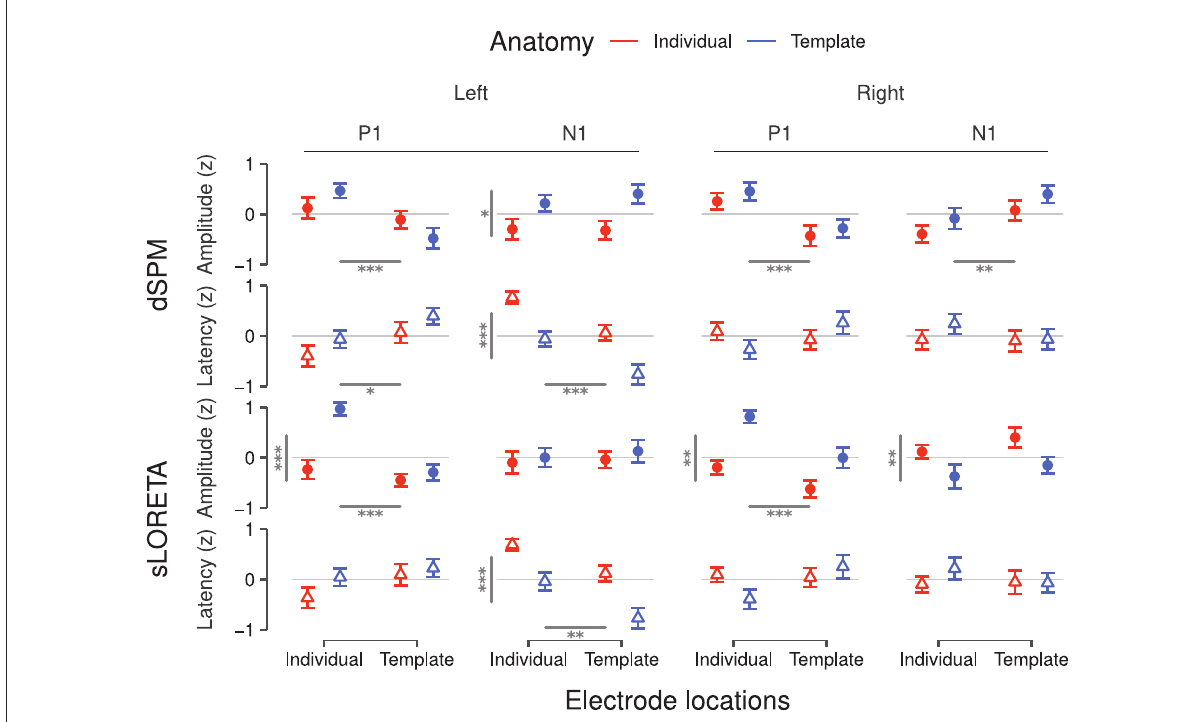
FIGURE3 Peak amplitudes and latencies for P1 and N1 components inferred via dSPM (top) and sLORETA (bottom) for the left and the right hemisphere. Values correspond to the average over subjects after z-scoring per condition and within subject. Error bars denote the SEM. Statistically significant main effects are reported as gray bars—horizontal bars for electrode position and vertical bars for brain anatomy—and from one to three asterisks indicating the significance levels ( ∗ p < 0.05, ∗∗ p < 0.01, ∗∗∗ p < 0.001). Significant interactions are reported in Table